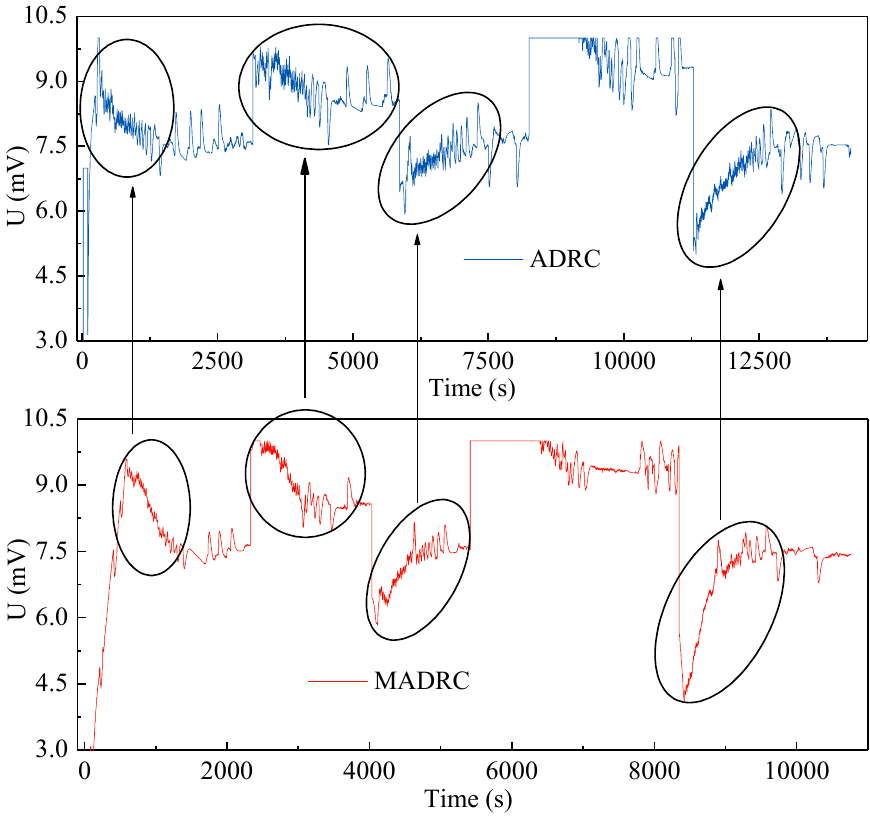
Figure 15. Comparison of control variable fluctuations.